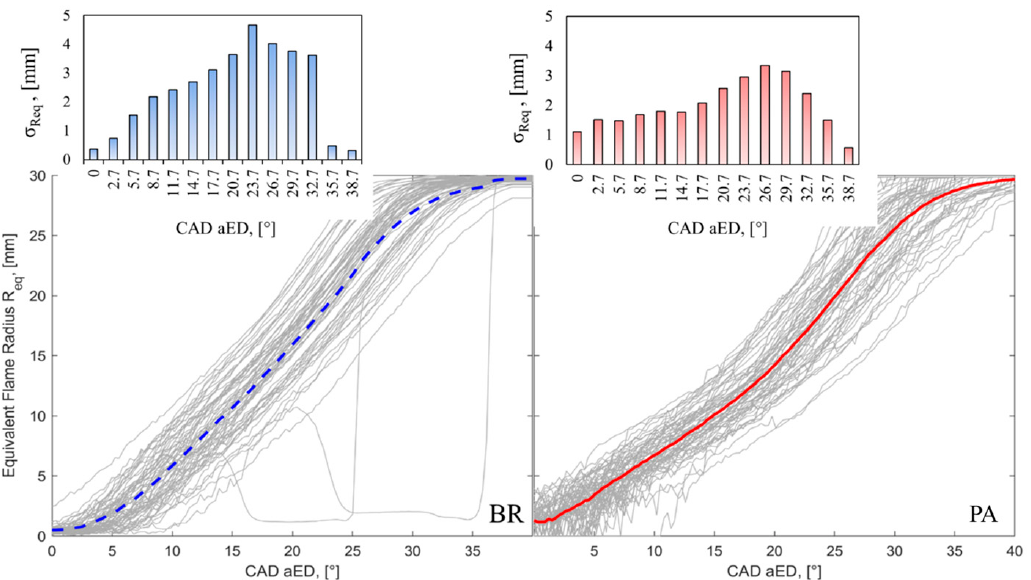
Figure 9. Overlap of the binarized Target images and CNN ones and quantification of the corre- sponding equivalent flame area. The overestimation is indicated by green flame area whereas the underestimations with violet.